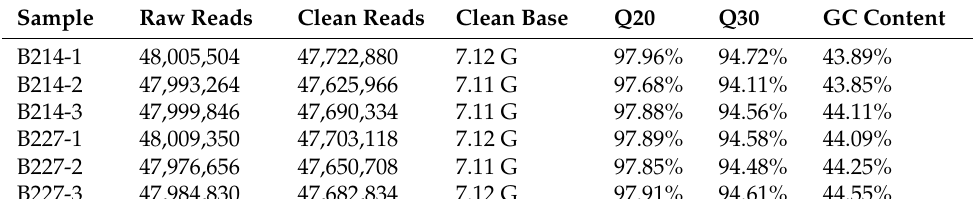
Table 1. Summary of RNA sequencing results after Illumina sequencing of B214 and B227. Sample